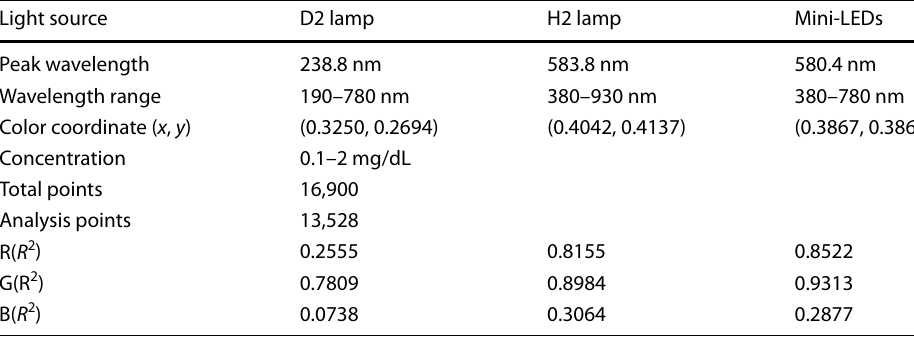
Table 2 Color images analysis for test paper using different light